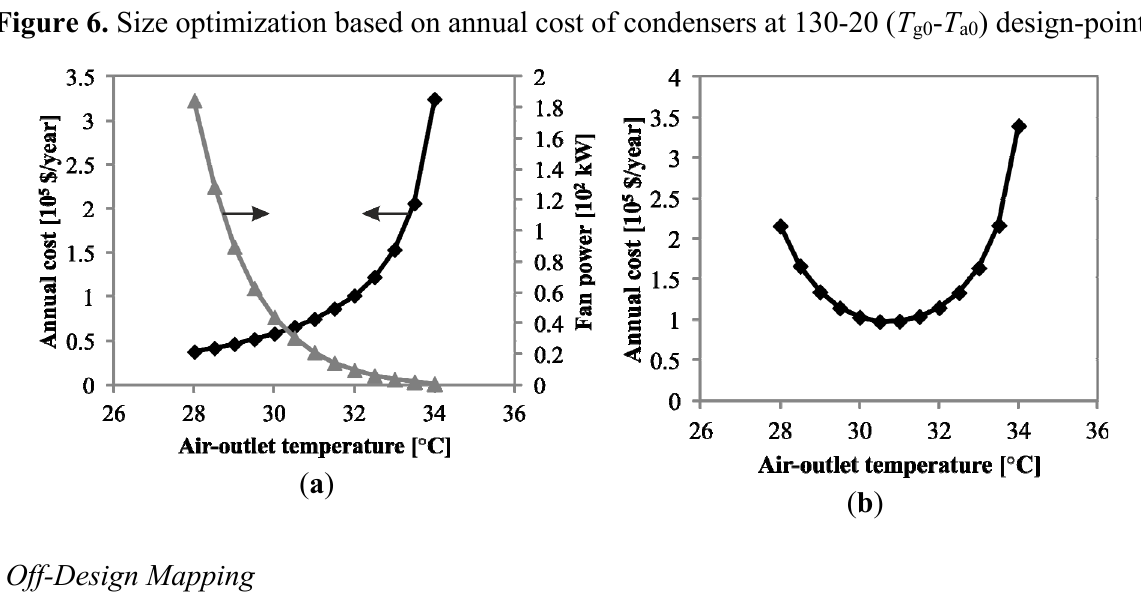
Figure 6. Size optimization based on annual cost of condensers at 130-20 ( T